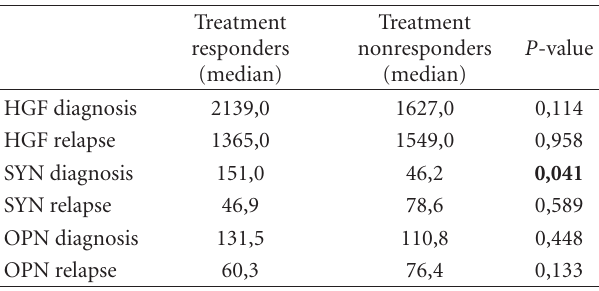
Figure 3: Comparison of serum levels of osteopontin (OPN) in di ff erent phases of multiple myeloma and in monoclonal gammopathy of undetermined significance. Vertical axis: serum levels of osteopontin (OPN, OSTEOP, ng/mL). Horizontal axis: (A) multiple myeloma at the time of diagnosis, (B) multiple myeloma (MM) in relapse/progression, (C) remission phase mul- tiple myeloma, (D) monoclonal gammopathy of undetermined significance (MGUS). The di ff erences between active phase MM (A versus B) and remission phase myeloma and MGUS (C and D) were not statistically di ff erent. The di ff erence between MM in relapse/progression and remission phase MM was not significant, either. Significant di ff erences were found between MM at the time of diagnosis and remission phase myeloma (A versus C; M 123,1 versus 66,55 ng/mL, P = 0,0003), MM at the time of diagnosis and MGUS (A versus D; M 123,1 versus 52,485 ng/mL, P < 0,0001), and MM in relapse/progression and MGUS (B versus D; M 74,975 versus 52,485 ng/mL, P = 0,0001). Table 2: Di ff erences of pretreatment serum levels of hepatocyte growth factor, syndecan-1, and osteopontin in multiple myeloma treatment responders and